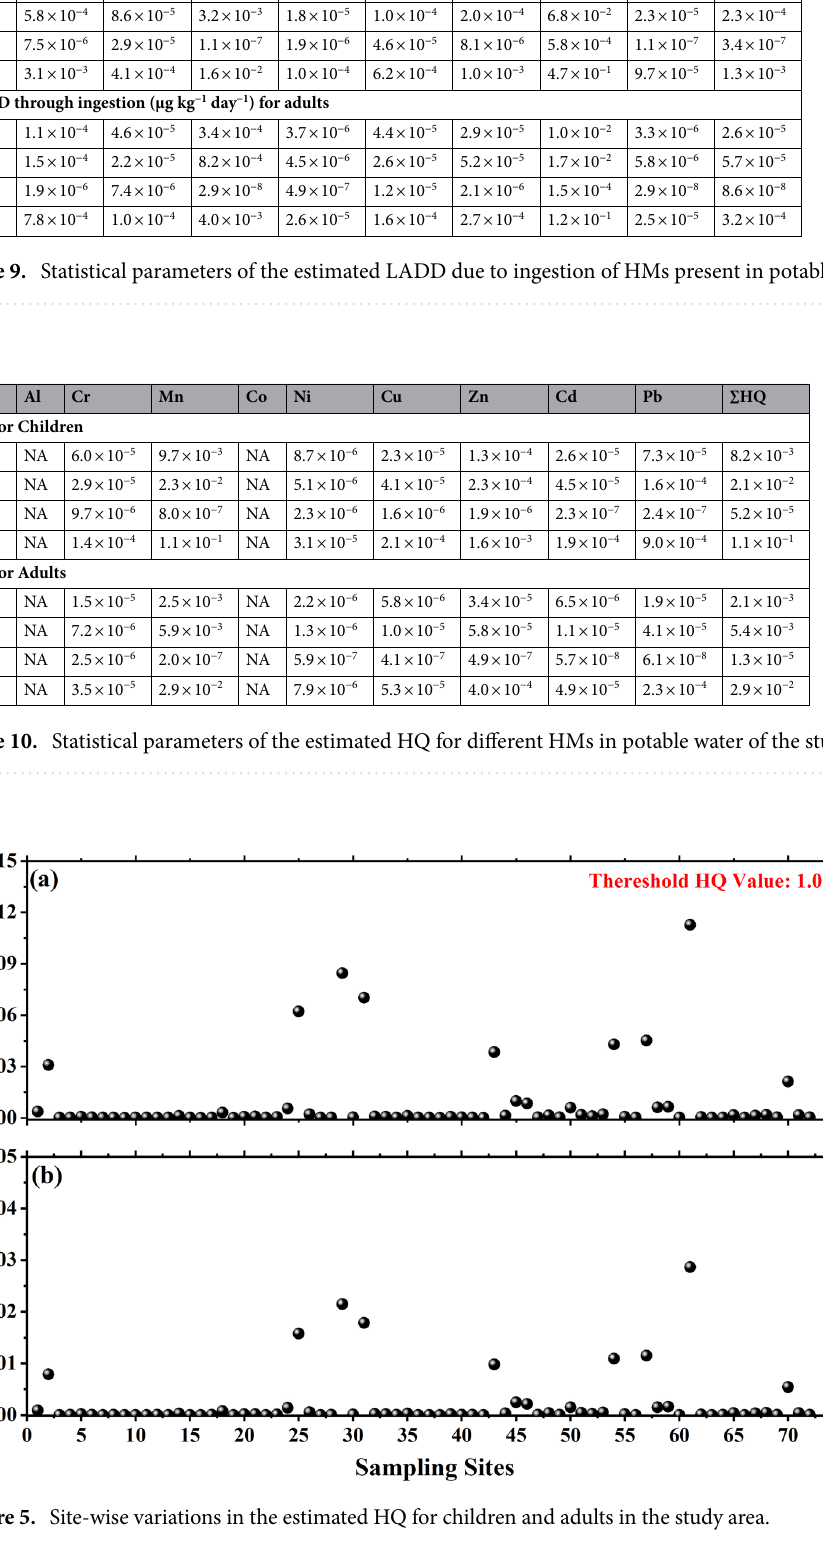
Figure 5. Site-wise variations in the estimated HQ for children and adults in the study